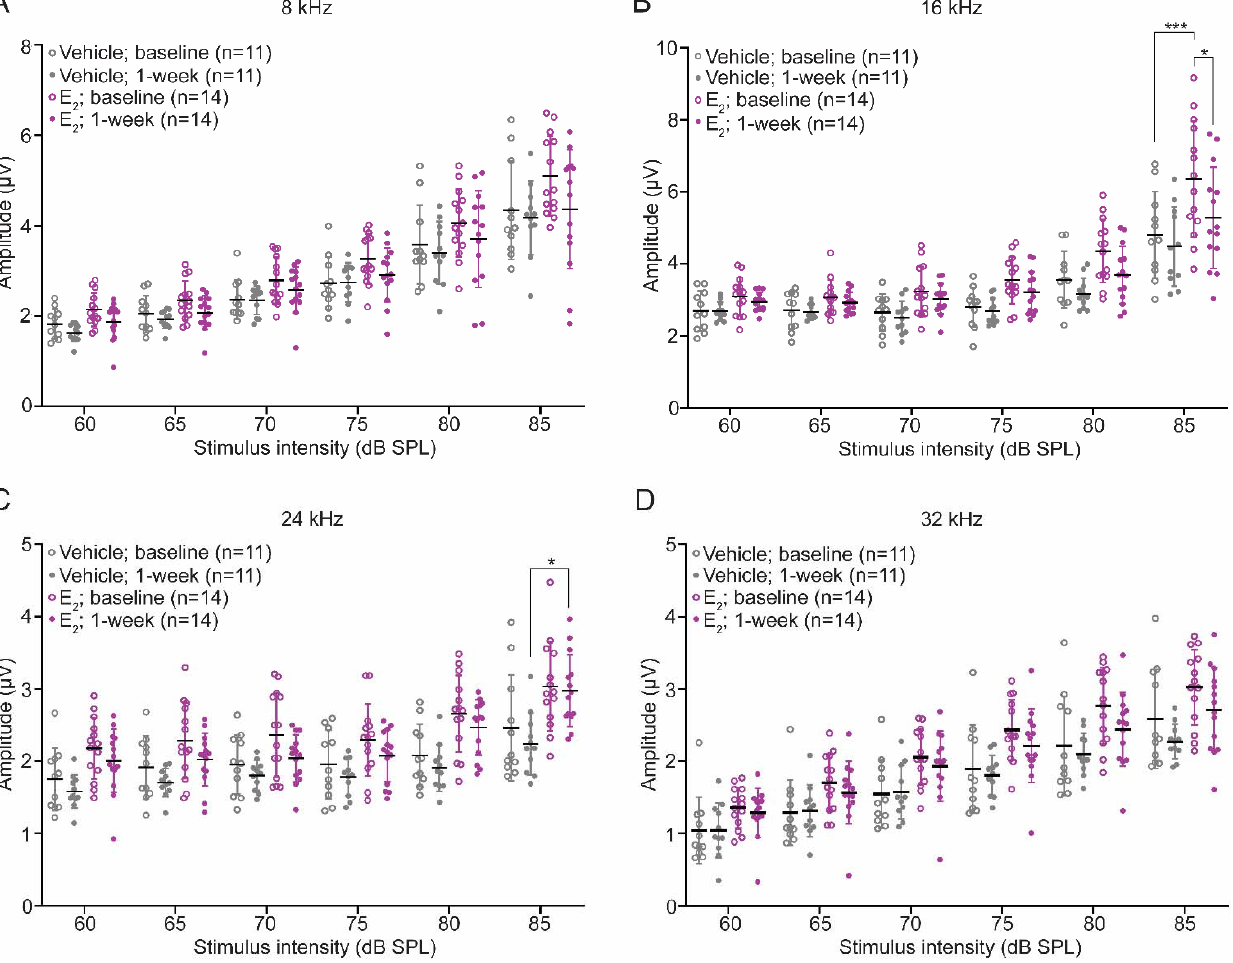
Figure 6. E 2 -replacement in gonadectomized female mice increases wave-1 amplitudes before and after a TTS-inducing noise exposure. ( A – D ): Wave-1 amplitudes in vehicle-treated and E 2 -treated mice at baseline and 1-week post-exposure. Female mice were gonadectomized at 8-weeks of age and treated with vehicle or E 2 (150 µg/kg) beginning 2-days after the gonadectomy for the remaining duration of the study. Animals were exposed to a TTS-inducing noise (94 dB SPL, 8–16 kHz, 2-h) at 10-weeks of age. Wave-1 amplitudes were quantified via ABR measurements 1-week pre-exposure (baseline) and 1-week post-exposure. ( B ) At baseline, E 2 -treated mice display larger wave-1 amplitudes at 16 kHz: 85 dB SPL ( p = 0.0001). ( C ) One-week post-exposure E 2 -treated female mice display larger wave-1 amplitudes at 24 kHz: 85 dB SPL ( p = 0.0111). Wave-1 amplitudes were compared using a 3-way ANOVA followed by Tukey’s post hoc test. n = number of mice; Wave-1 amplitude: mean ± SD; * p < 0.05, *** p < 0.001.